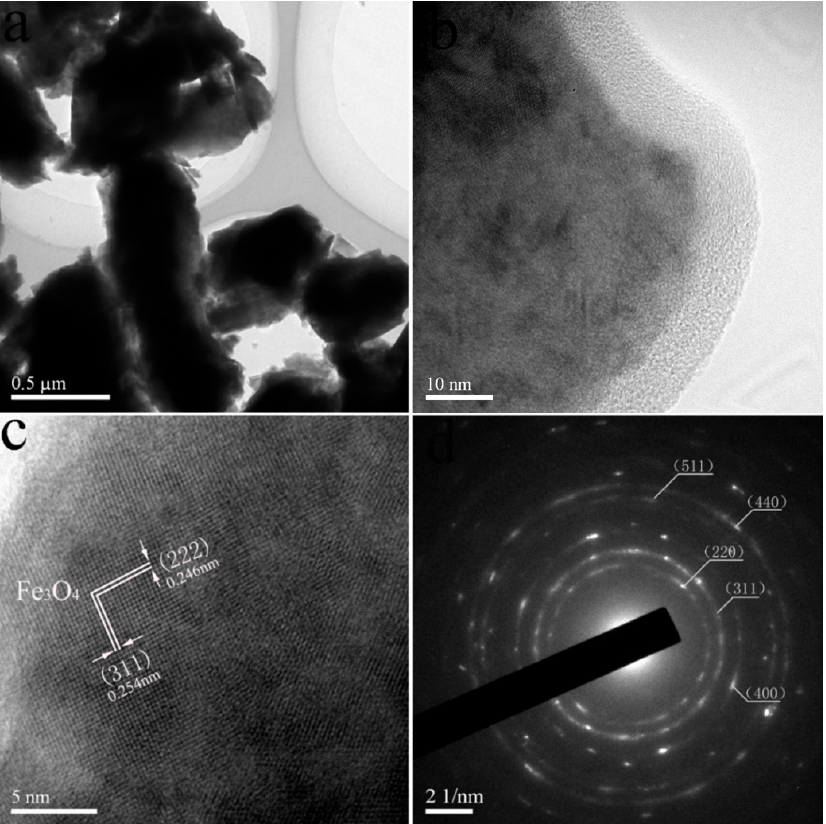
Figure 5. Different magnification TEM images ( a , b ), HRTEM image ( c ), and SAED pattern ( d ) of M3.